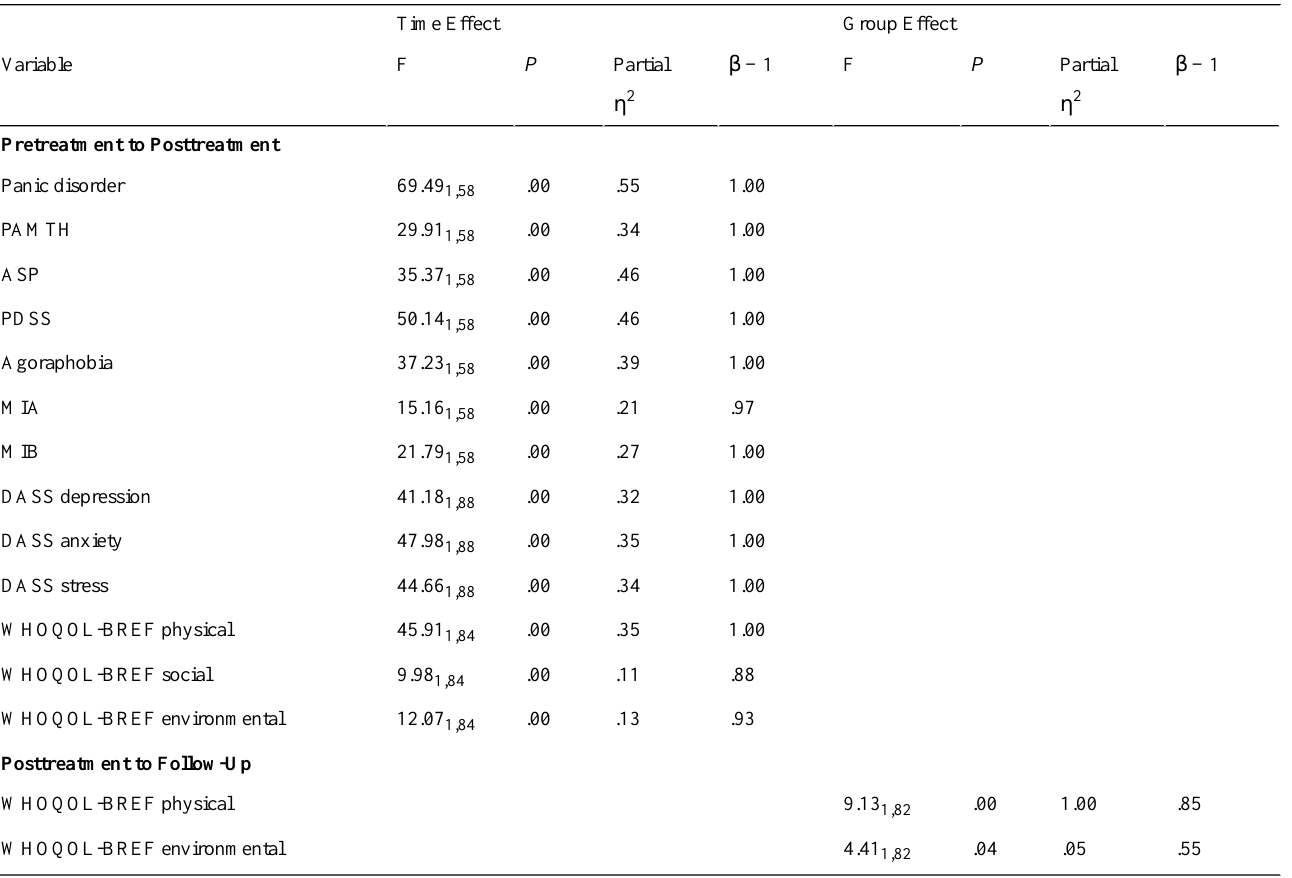
Table 8. Effects from univariate